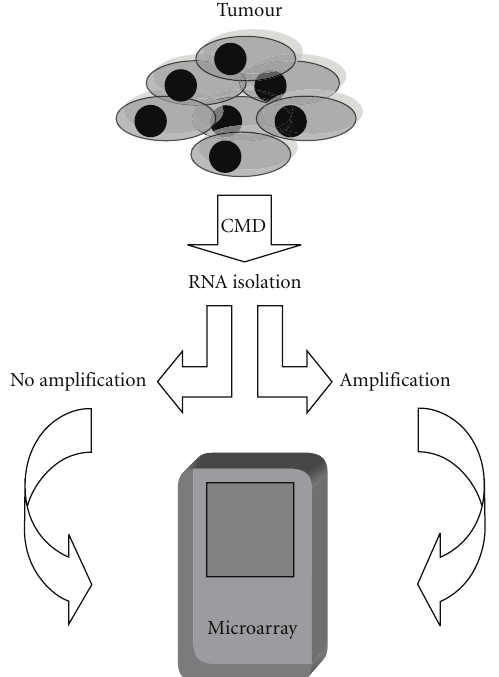
Figure 1: Experimental procedure. RNA was isolated from tumours after CMD; one part of the RNA underwent amplification and the other part was hybridized without preamplification to